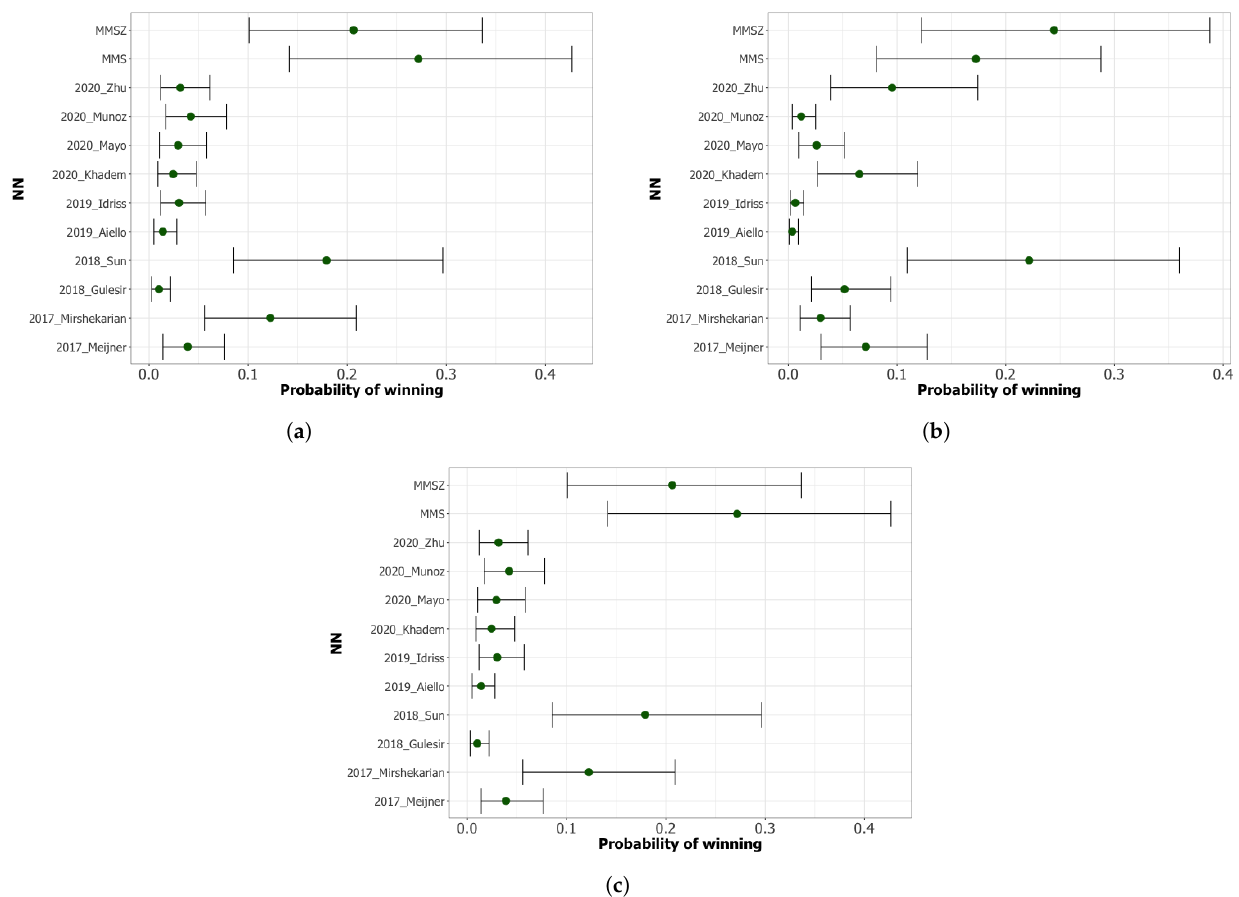
Figure 7. Ranking of the best NN using the scmamp method for different prediction horizons. ( a ) ph = 30min. ( b ) ph = 60min. ( c ) Multi-horizon. Table 14. p -values for the MCS for ph = 30,60,30 ∪ 60 with 1000 bootstrap replications and α = 0.05. Green cells in each column highlight the model with the best